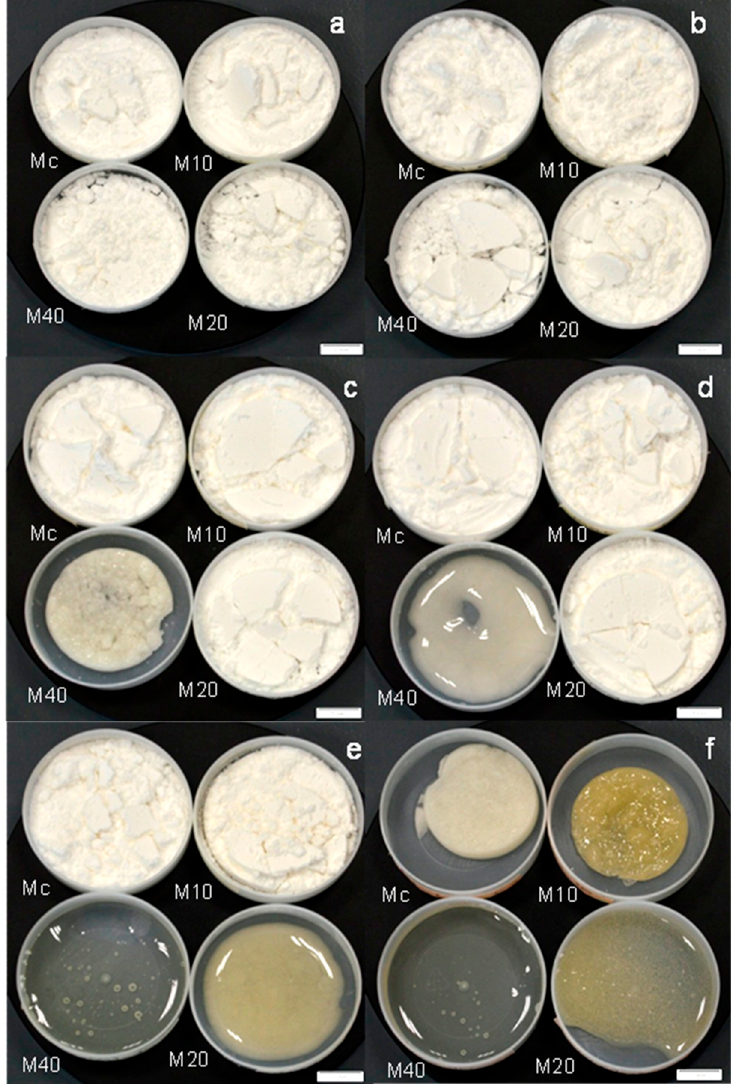
Figure 6. Optical micrographs of the MXs at the different water activities: Water activities are indicated by the letters: ( a ) 0.070; ( b ) 0.328; ( c ) 0.434; ( d ) 0.532; ( e ) 0.718; and ( f ) 0.75. The white scale bar is equal to 2 cm.